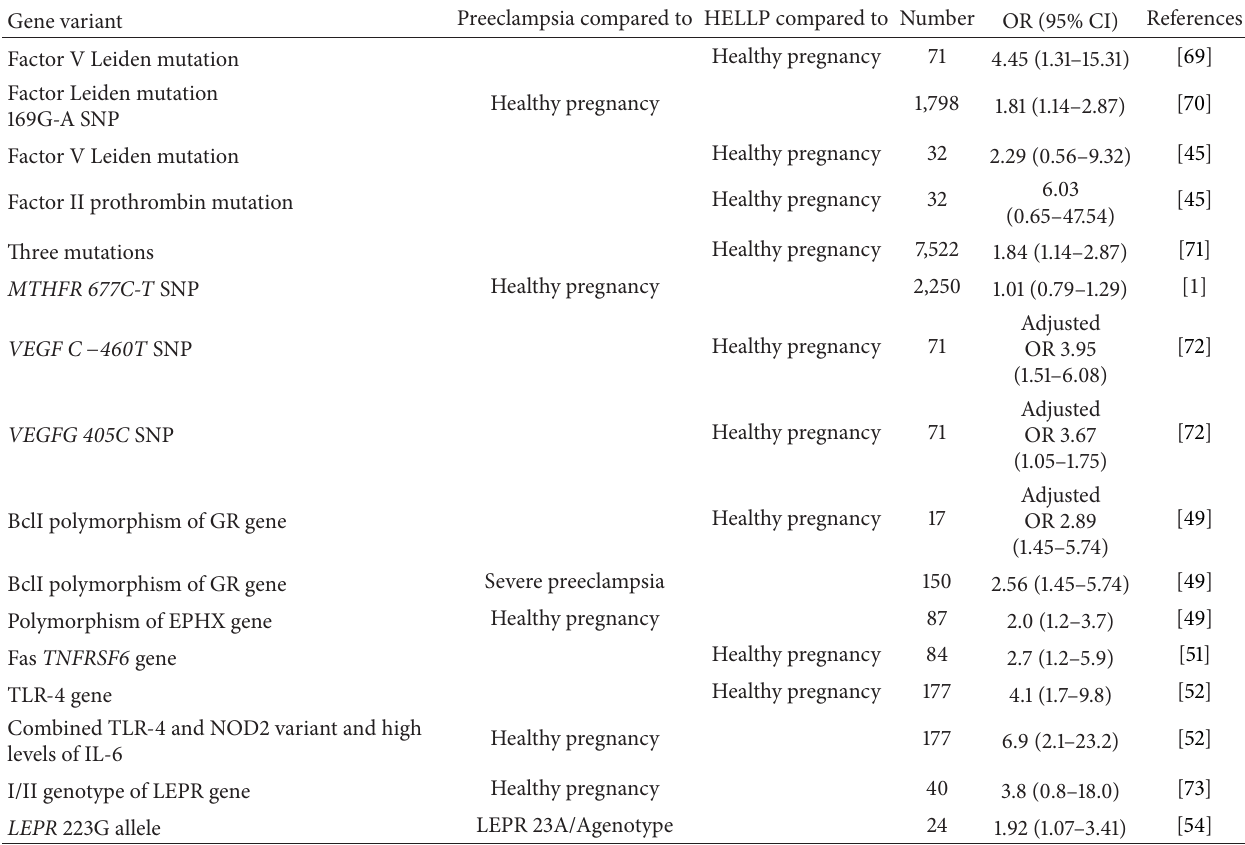
Table 2: OR impact on preeclampsia and